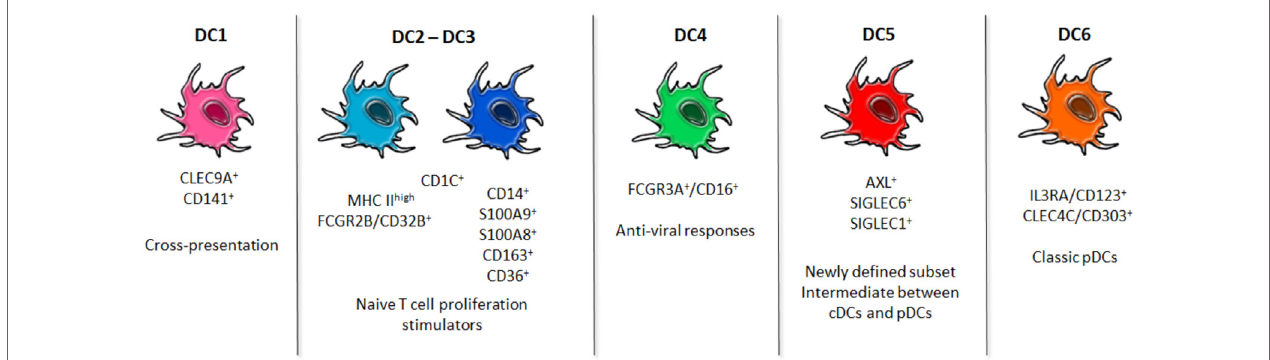
FiGURe 1 | Dendritic cells (DCs) readapted taxonomy. Newly identified populations of blood human DCs are shown. DC1 subset is clearly distinct by the expression of CLEC9A, and it is specialized in cross-presentation of ags. DC2 and DC3 constitute the conventional DCs pool, even though they appear to be phenotypically slightly different and, upon stimulation with TLR ligands, their diversity emerges. DC4 is a population characterized by an upregulated Type I Interferon pathway for antiviral responses. DC5 has emerged as a new population whose specific functions are still unexplored. DC6 corresponds to the classic plasmacytoid DCs. These advances in the fine characterization of DCs in humans may shed light on the best subset to be targeted to incentivize the desired immune